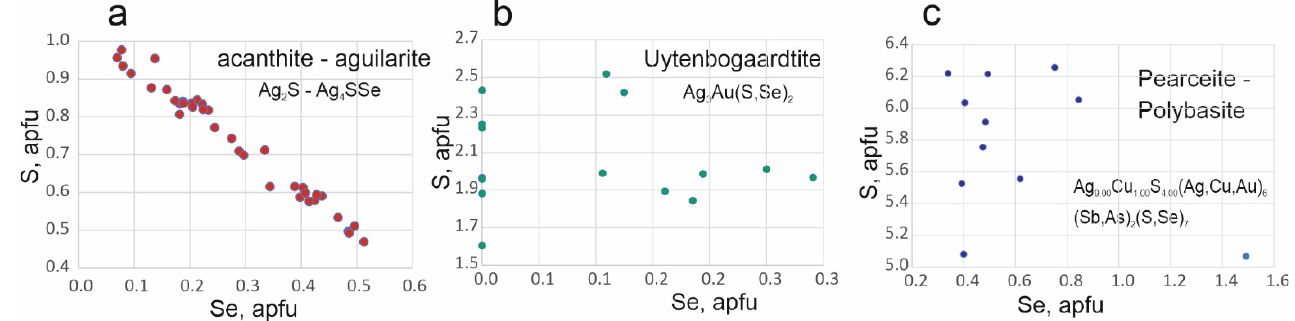
Figure 9. Sulfur versus selenium content (apfu) in the minerals acanthite-aguilarite ( a ), uy- tenbogaardtite ( b ), pearceite-polybasite ( c ). gaardtite ( b ), pearceite-polybasite ( c ).